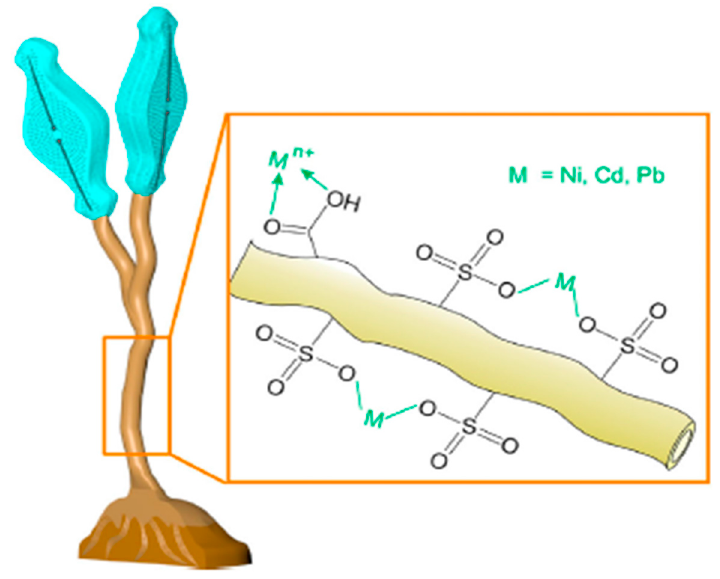
Figure 4. Schematic diagram for the adsorption of metal ions on D. geminata stalks [4]. The adsorption mechanism is based on ion exchange between groups on the adsorbent surface (hydroxyl and sulfonic groups) and metal ions, leading to the formation of coordination bonds, as one might observe in the diagram.